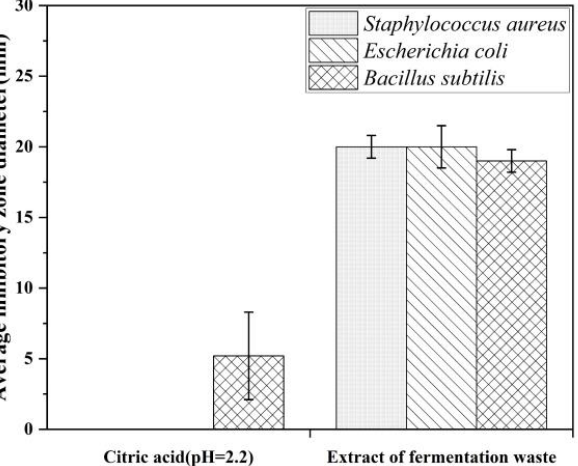
Figure 7. Bacteriostatic effect of the fermentation waste of greengage compared to citric acid solution. The data are shown as the mean values of three determinations (n = 3) ± standard deviation (error bars).